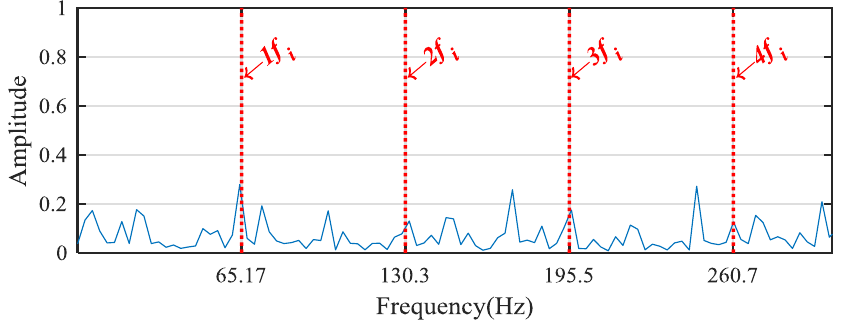
Figure 11. The envelope spectrum of the reconstructed signal.